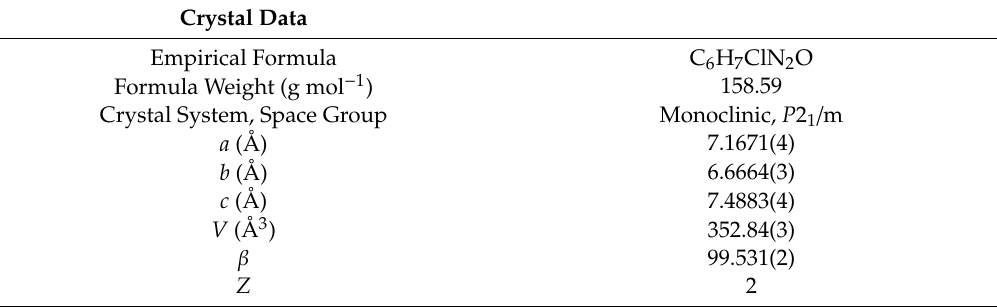
Table 1. Crystallographic parameters and data collection for (C 6 H 7 N 2 O) +